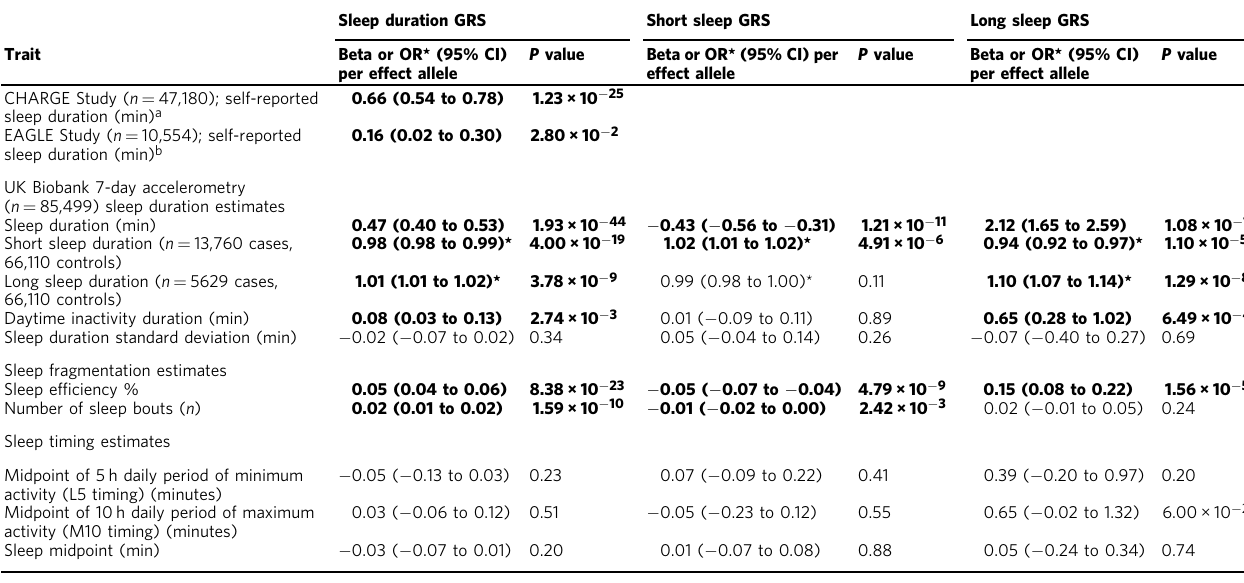
Table 1 A risk score of genetic variants for self-reported sleep duration (78 SNPs), self-reported short (27 SNPs) or long (8 SNPs) sleep duration associates with self-reported sleep duration in the CHARGE (adult) consortium ( n = 47,180), self-reported sleep duration in the EAGLE (childhood/adolescent) consortium ( n = 10,554), and activity-monitor-based measures of sleep fragmentation, timing, and duration from 7-day accelerometry in the UK Biobank ( n =